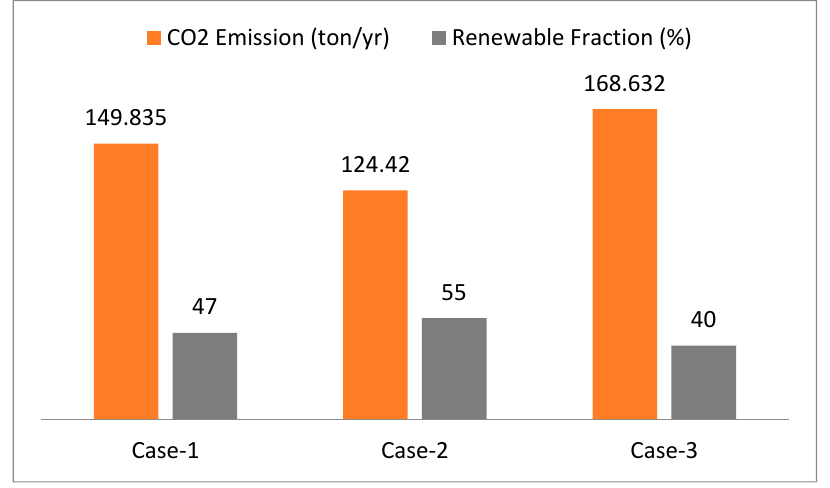
Figure 16. Renewable fraction and emissions incurred from the systems.